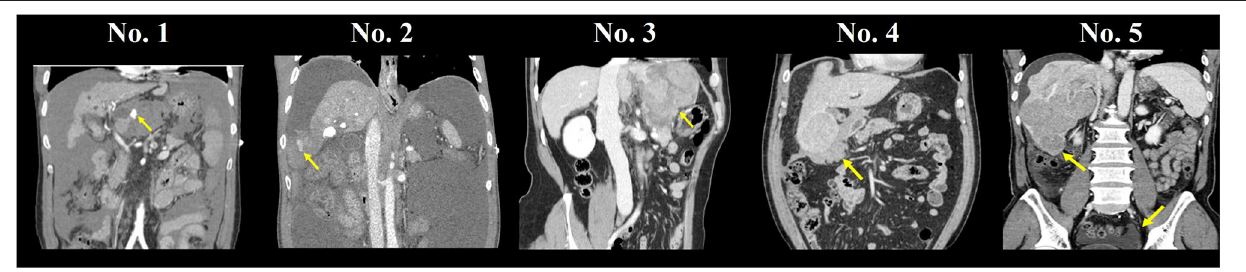
FIGURE 1 | Computed tomography scan of a ruptured hepatocellular